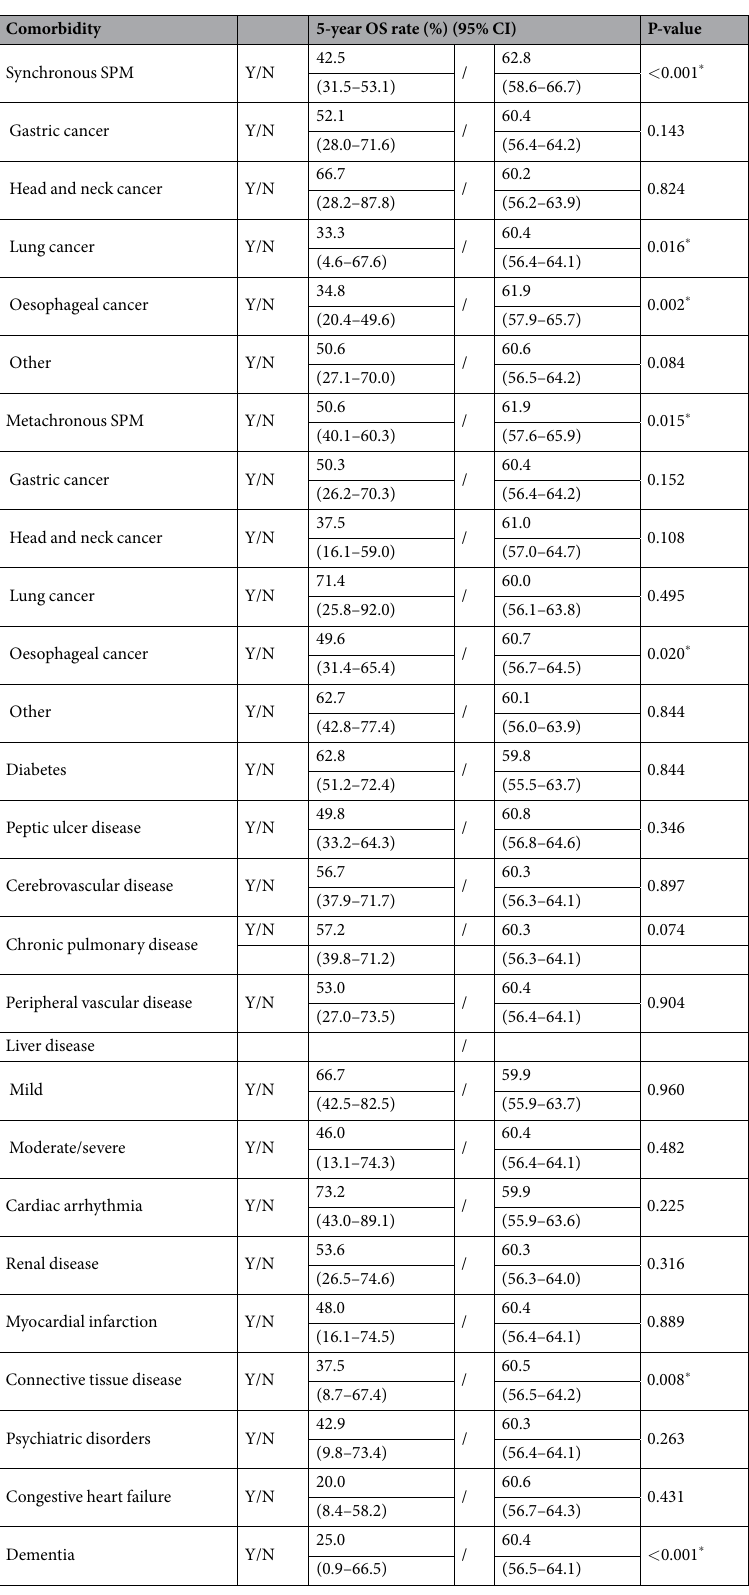
Table 3. Impact of comorbidities on 5-year overall survival (OS) in patients with head and neck squamous cell carcinoma in the training set. * P < 0.05. CI, confidence interval; N, no; Y,